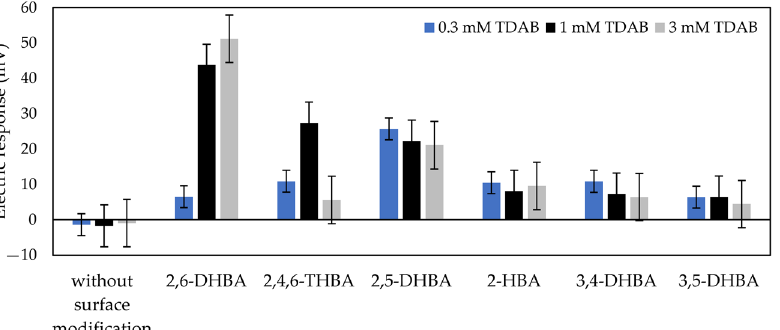
Figure 6. Electric response to 100 mM caffeine when using lipid/polymer membrane modified with six types of HBA. The error bar expresses the SD, of the data, of n = 4 (electrode) × 4 (rotation) = 16 values.